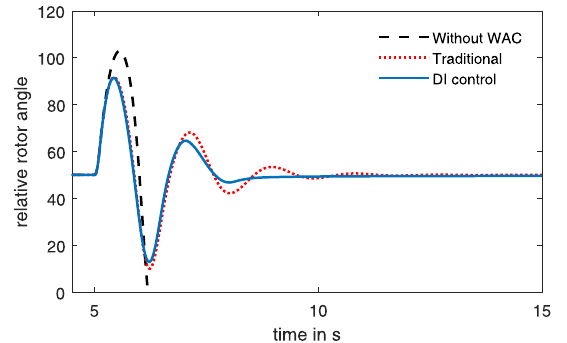
Fig. 8 Relative rotor angle deviations in the worst fault scenario